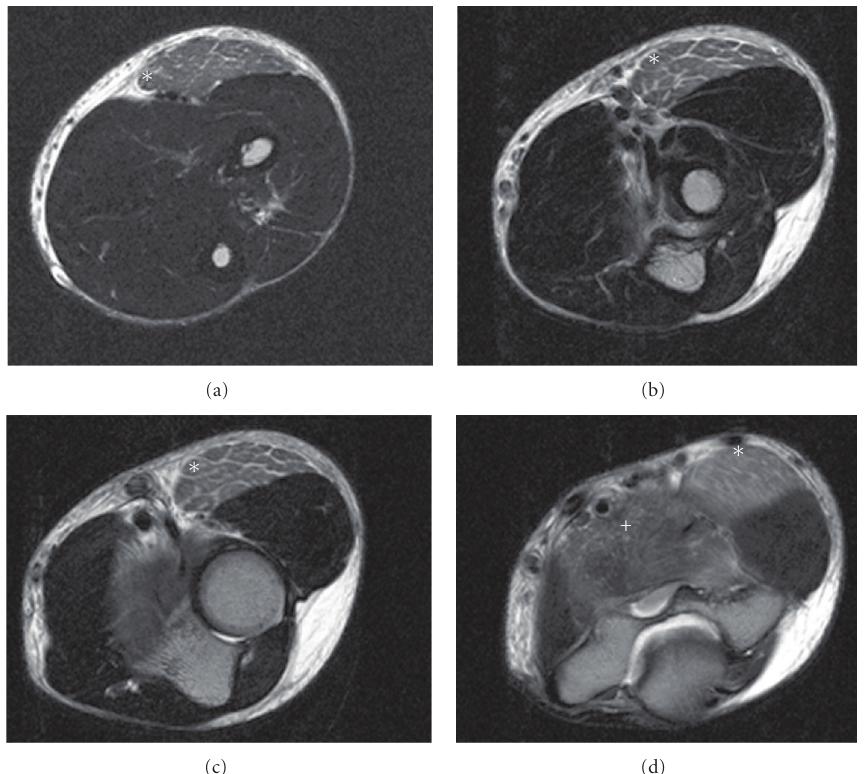
Figure 2: MRI of the right elbow (transversal T2w TSE) shows homogenous signal increase in the brachioradial (marked as ∗ ) and the brachial muscle (marked as +